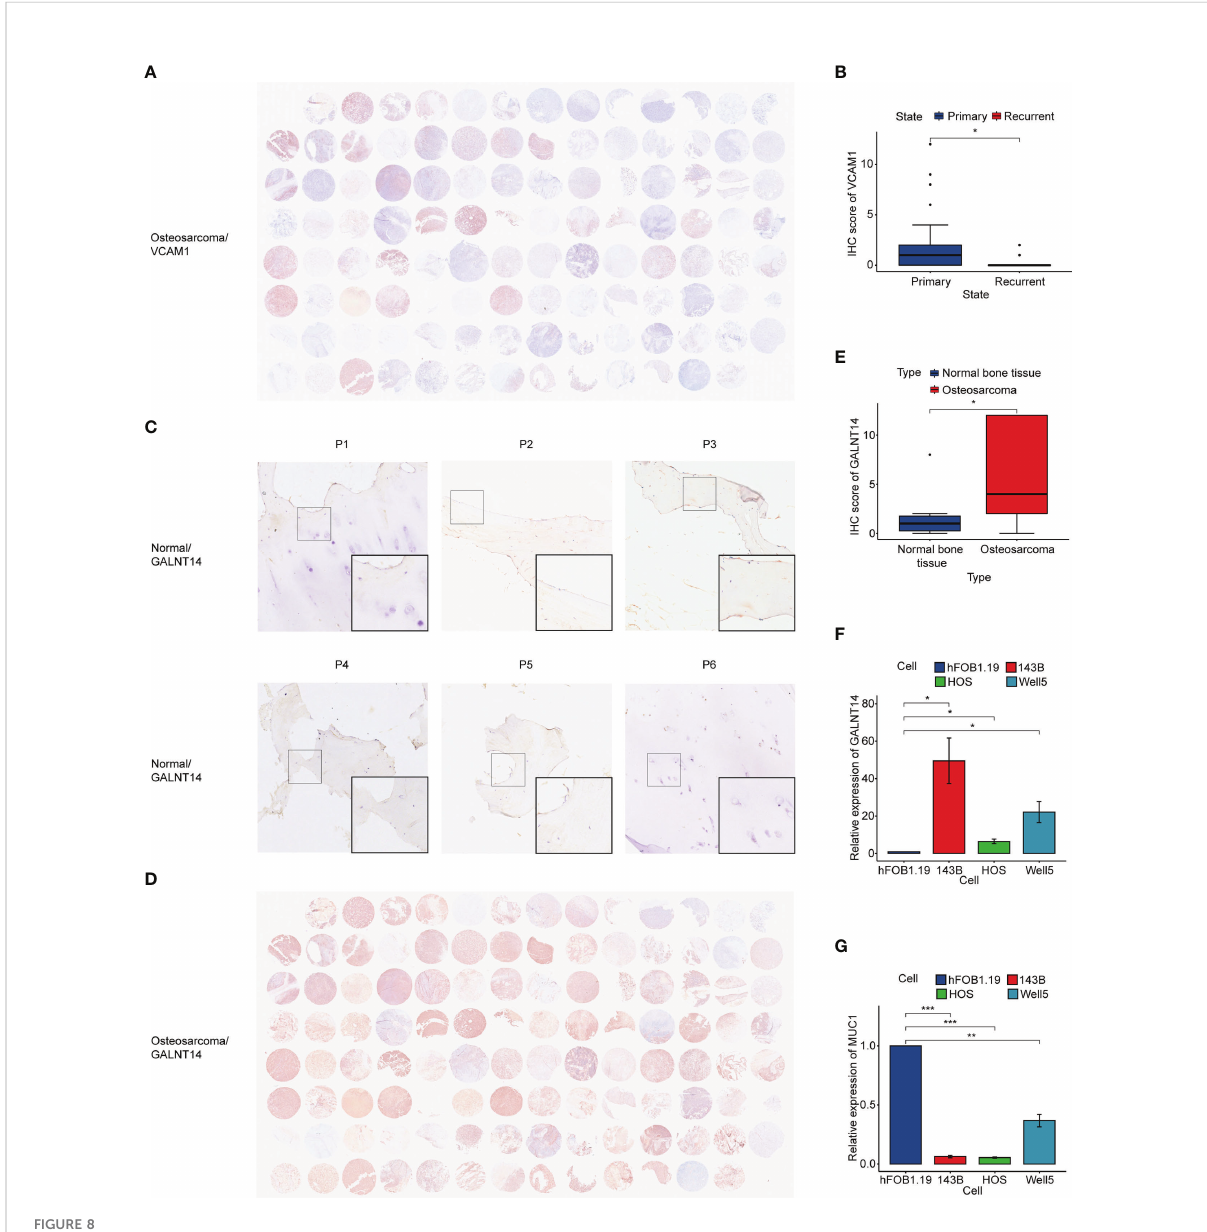
FIGURE 8 Immunohistochemistry and qRT-PCR. (A) Immunohistochemistry of VCAM1 in osteosarcoma tissue. (B) IHC score of VCAM1 between the primary osteosarcoma group and the recurrent osteosarcoma group. (C) Immunohistochemistry of GALNT14 in normal bone tissue. (D) Immunohistochemistry of GALNT14 in osteosarcoma tissue. (E) IHC score of GALNT14 between normal bone tissue and osteosarcoma tissue. (F, G) qRT-PCR results of GALNT14 and MUC1 in osteoblast cell line and three osteosarcoma cell lines. (* p < 0.05, ** p < 0.01, *** p <